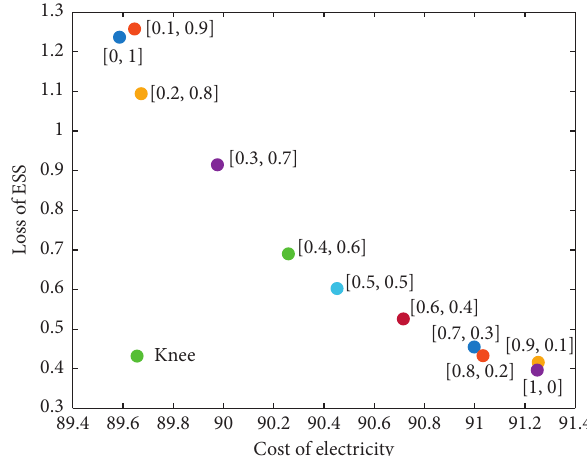
Figure 8: Solutions distribution of WS and